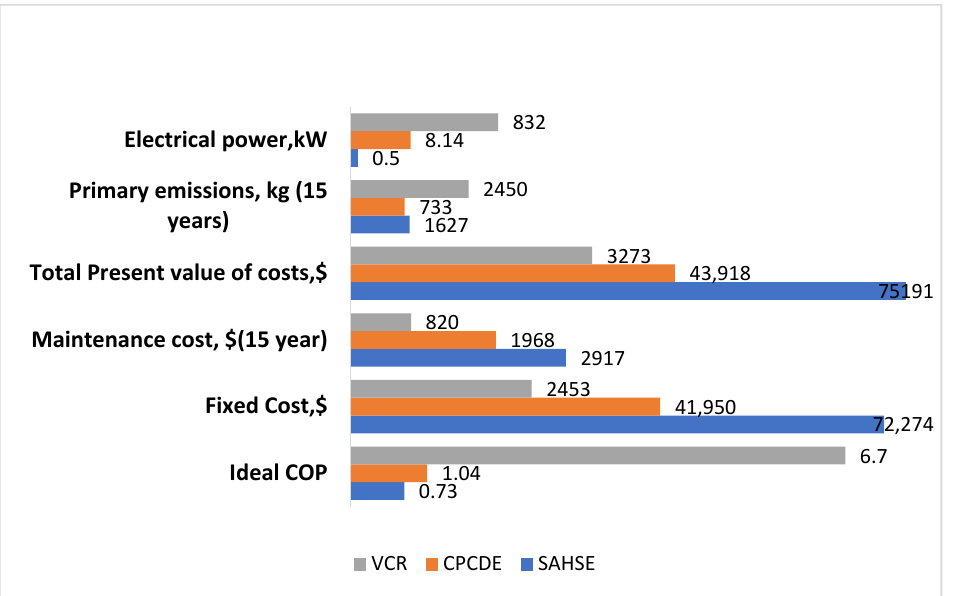
Figure 11. Comparison of performance of the best ranking single effect solar method (SWHSE), double effect solar method (CPCDE) and vapor compression method (VCR) for Beijing (Dwa).